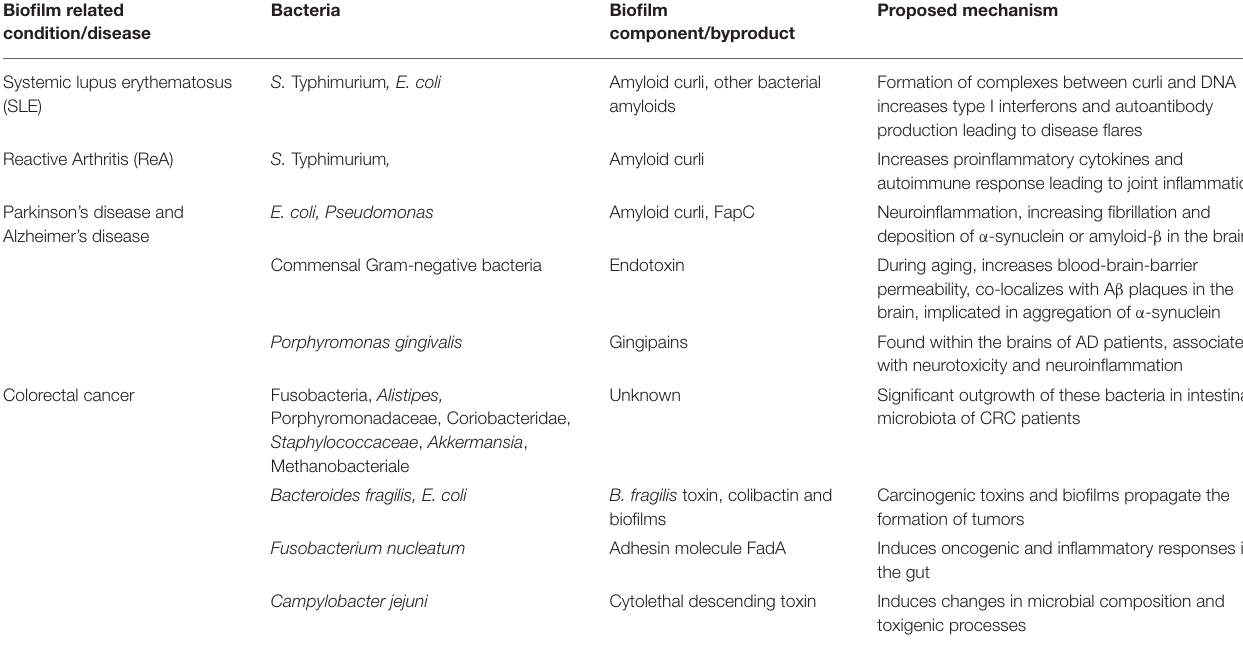
TABLE 1 | Human diseases exaggerated by bacterial biofilms or biofilm by-products. Biofilm related